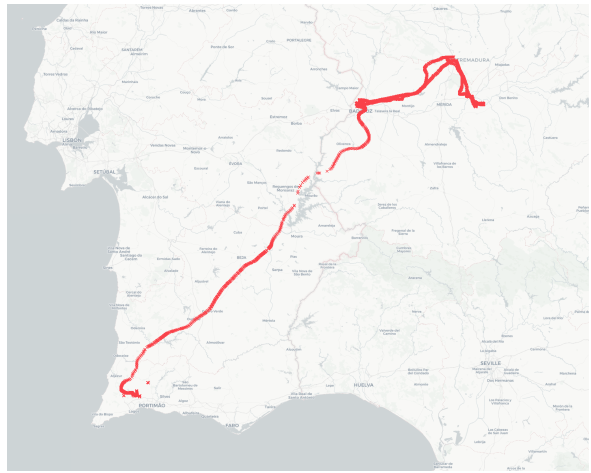
Figure 5. A plot of the other main area of the STAGA GPS samples. The dataset’s second-largest chunk of interrelated samples was projected onto Portugal and Spain.